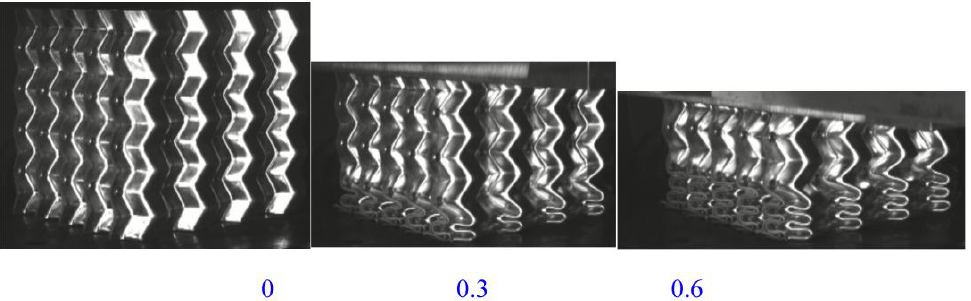
Figure 10. Dynamic test process under axial direction.